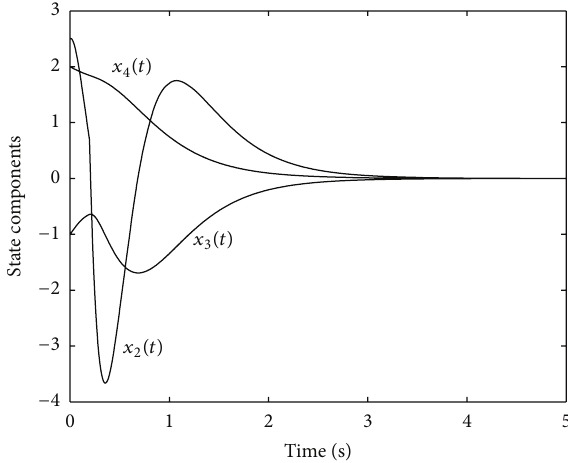
Figure 12: Evolution of the state components 𝑥 2 (𝑡) , 𝑥 3 (𝑡) , and 𝑥 4 (𝑡)